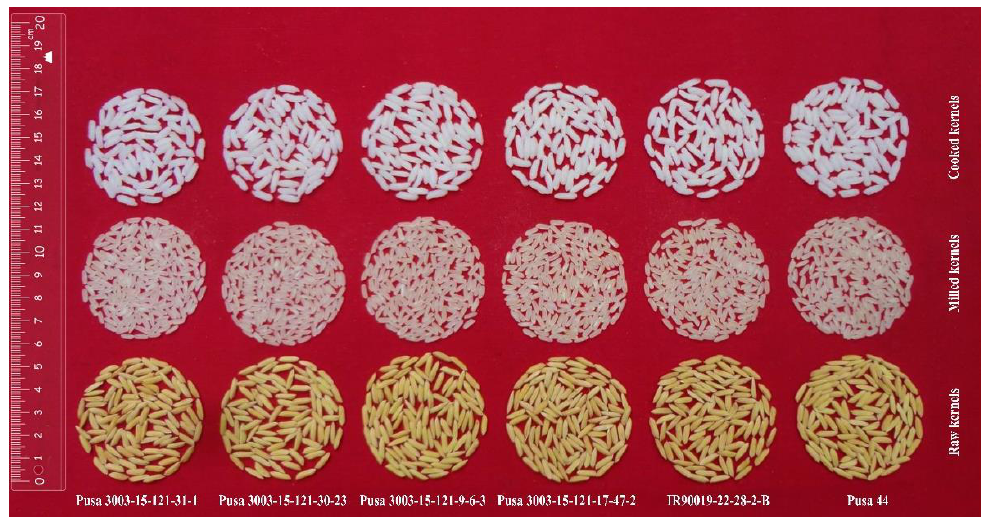
Figure 4. Grain morphology of the selected Pusa 44 qDTY12.1 -NILs, showing remarkable recovery of grain and cooking quality.